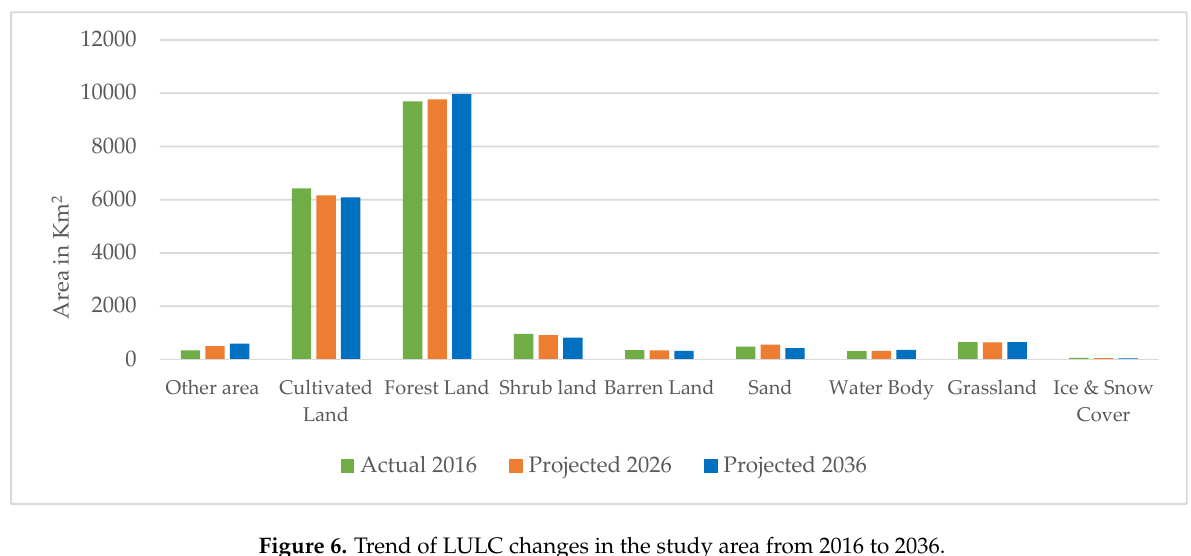
Figure 6. Trend of LULC changes in the study area from 2016 to 2036.